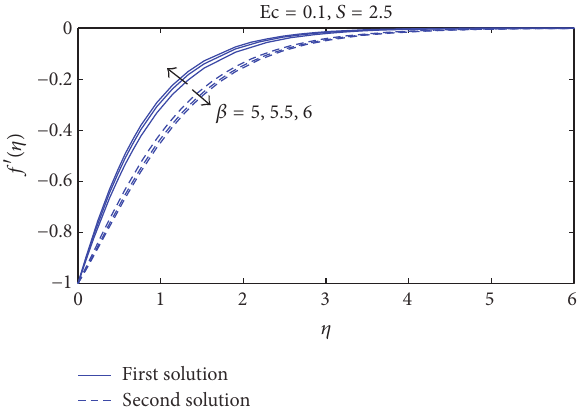
Figure 5: Heat transfer coefficient −𝜃 󸀠 (0) with 𝑆 for different values of Pr.